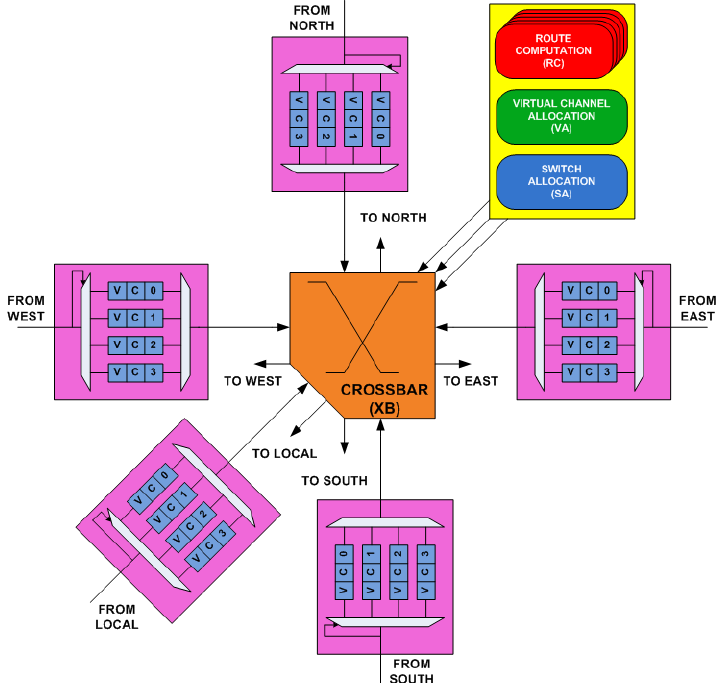
Figure 1. Generic